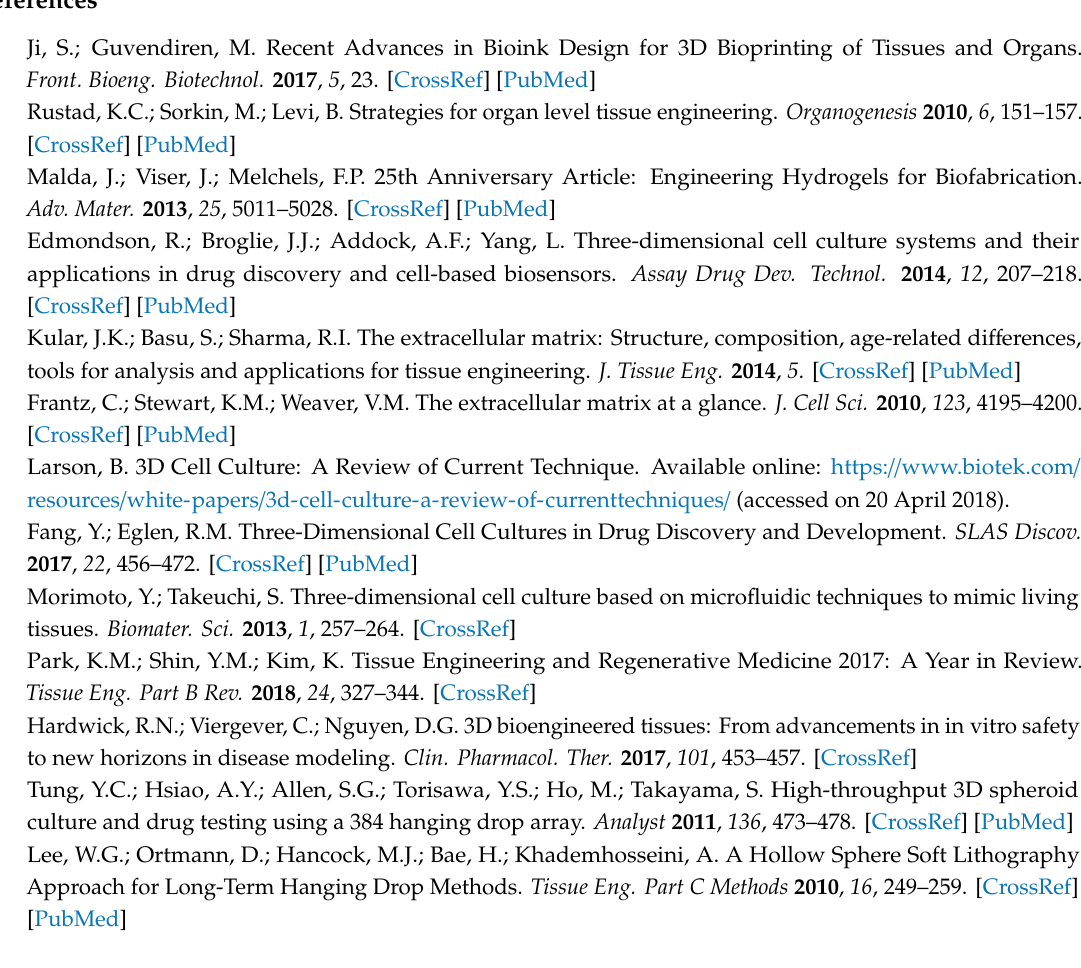
Figure S1. Schematics of our high-throughput method for preparation of keratinocyte cell spheroids (A–D). Figure S2. Optical microscopy images of HaCaT cell droplets (PEO 5.5 wt% / DEX 5.5 wt%) stabilized by 2 wt% WP particles, at di ff erent stage of homogenization. Figure S3. Average DEX droplet diameter for the formulation of WP / NaCl 300mM solution at pH 5.8, PEO 5.5 wt% / DEX 5.5 wt% homogenized by 1, 2 or 3 pumps. Figure S4. Optical microscopy images of (A to C) HaCaT cell ( ф = 0.2) droplets (PEO 5.5 wt% / DEX 5.5 wt%) and (D to F) HaCaT cell spheroids (PEO 10 wt% / DEX 5.5 wt%) stabilized by 2 wt% WP particles. Figure S5. Optical microscopy images of (A to C) HaCaT cell ( ф = 0.25) droplets (PEO 5.5 wt% / DEX 5.5 wt%) and (D to F) HaCaT cell spheroids (PEO 10 wt% / DEX 5.5 wt%) stabilized by 2 wt% WP particles. Figure S6. Average HaCaT spheroid diameter for emulsions (A) PEO 5.5 wt or PEO 8wt% ф HaCaT = 0.0909, (B) PEO 5.5 wt% or PEO 10 wt% ф HaCaT = 0.2 and (C) PEO 5.5 wt% or PEO 10wt% ф HaCaT = 0.25. Figure S7. Optical microscopy images of (A to C) HaCaT cell droplets (PEO 5.5 wt% / DEX 5.5 wt%) and (D to F) HaCaT cell spheroids (PEO 10 wt% / DEX 5.5 wt%) stabilized by 2 wt% WP particles. ф HaCaT = 0.25 and ф Dex = 0.2. Figure S8. Growth of individual HaCaT cells incorporated with 0.75 wt% sodium alginate in DMEM media followed by cross-linking with 1 M CaCl 2 . Figure S9. Growth curves of spheroids spontaneously formed from individual HaCaT cells (triangle symbols) and pre-formed HaCaT spheroids by our method (circle symbols) both incorporated within a film of 0.75 wt% sodium alginate in DMEM media followed by cross-linking with 1 M CaCl 2